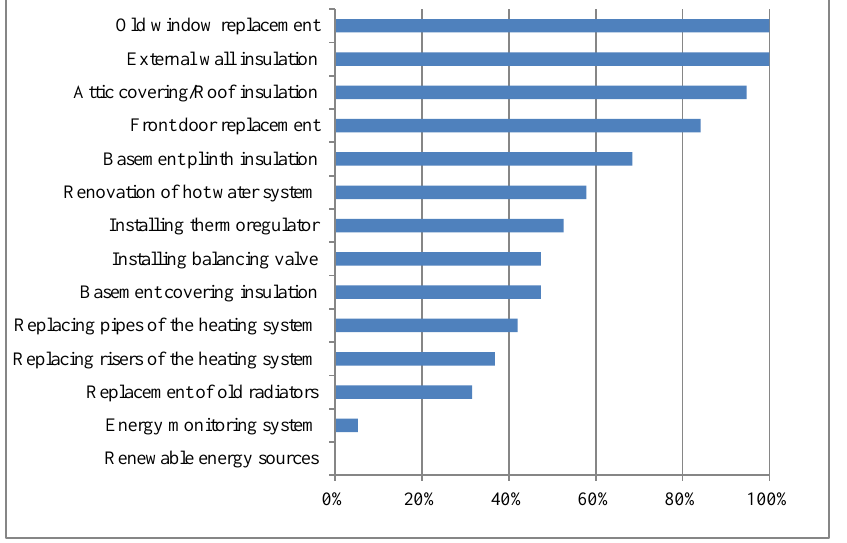
Fig. 1. Implemented energy efficiency